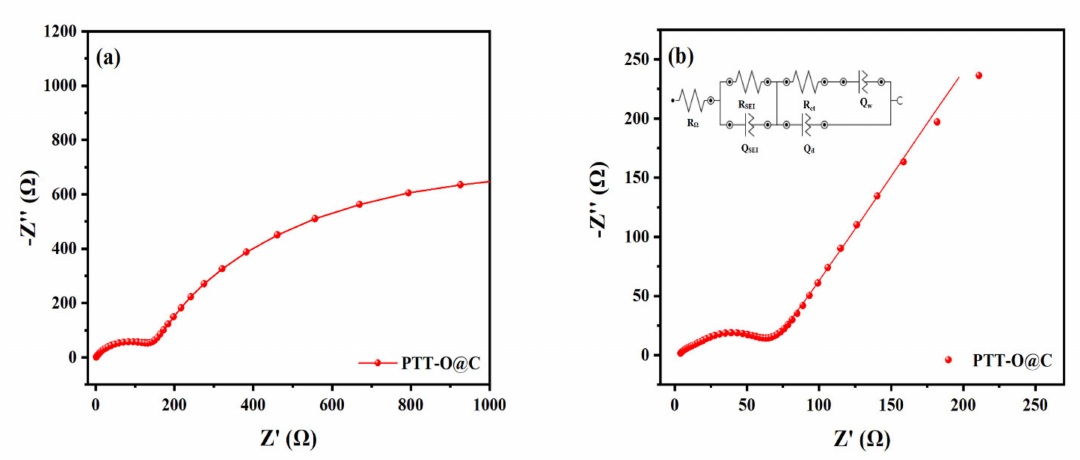
Figure 10. EIS spectra of PTT-O@C ( a ) at open-circuit voltage ( b ) at polarization